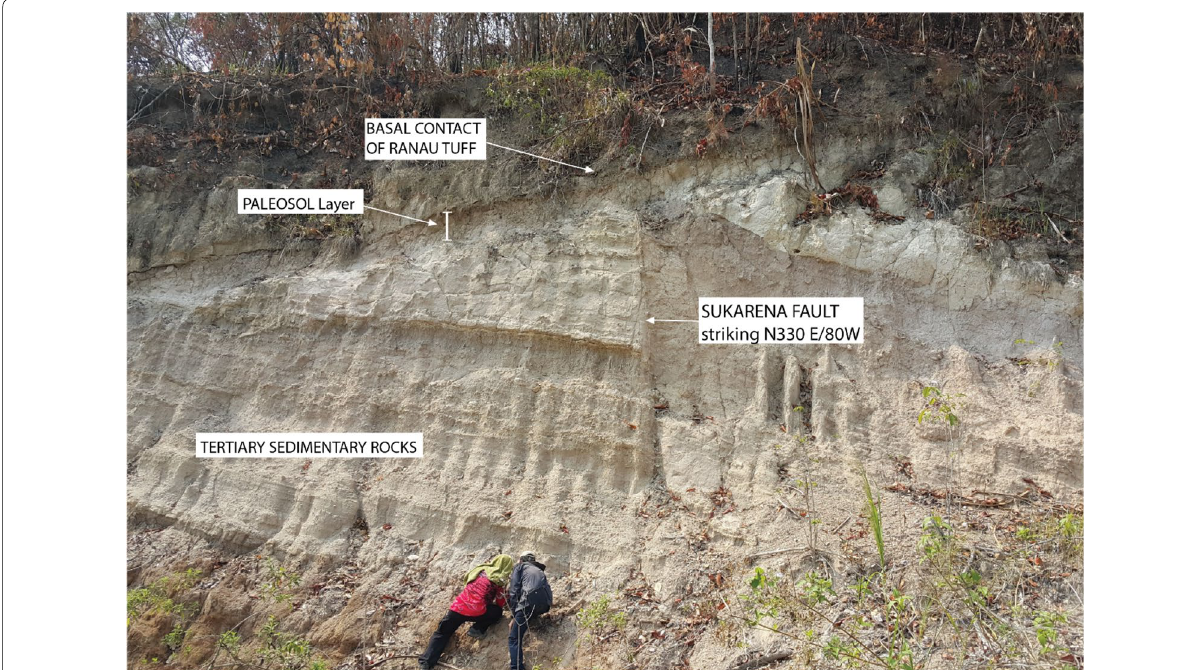
Fig. 4 Road cut exposure (Lat, Lon: 4.669773, 104.050126) between Muaradua and Ranau Lake of the inactive Sukarena Fault, which is overlain by − the undeformed Ranau Tuff. Location of this outcrop is marked in Fig. 2